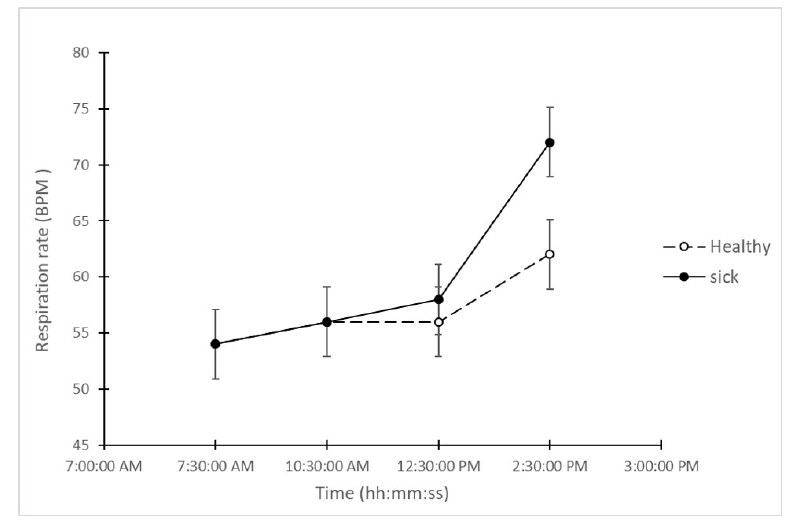
Figure 4. Average measurements of respiration rate (breath per minute) in “sick” and “healthy” animals at all 4 time points during the day after the challenge.